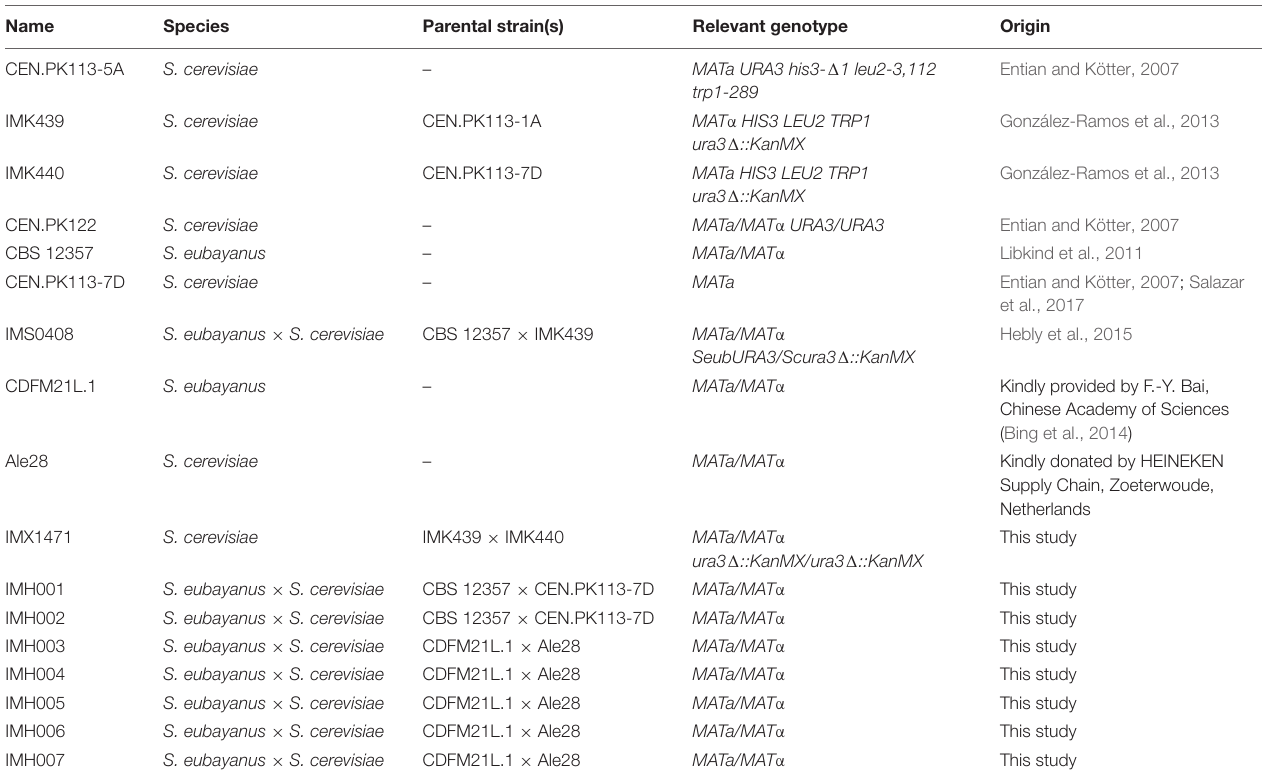
TABLE 1 | Saccharomyces strains used in this